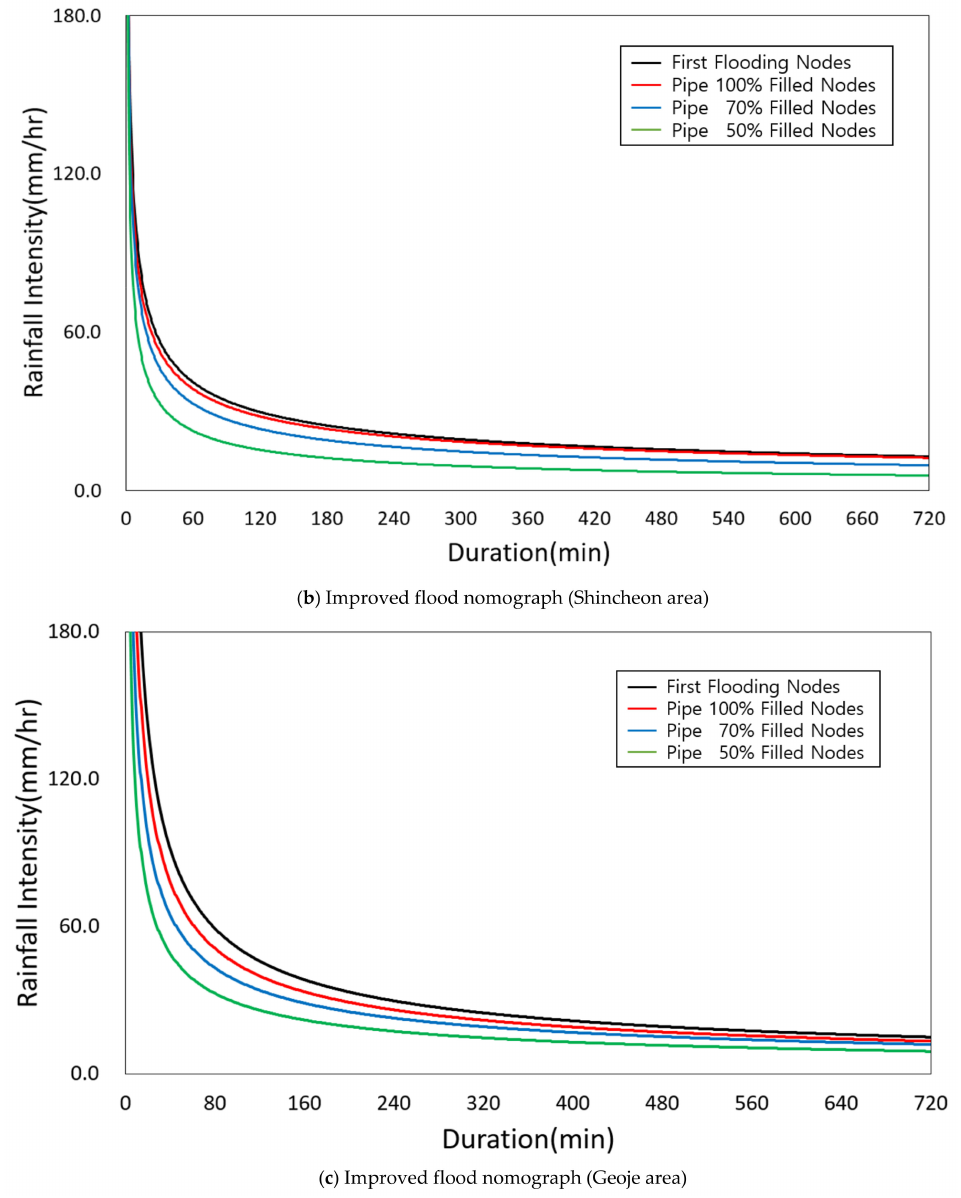
Figure 8. The generation process of improved flood